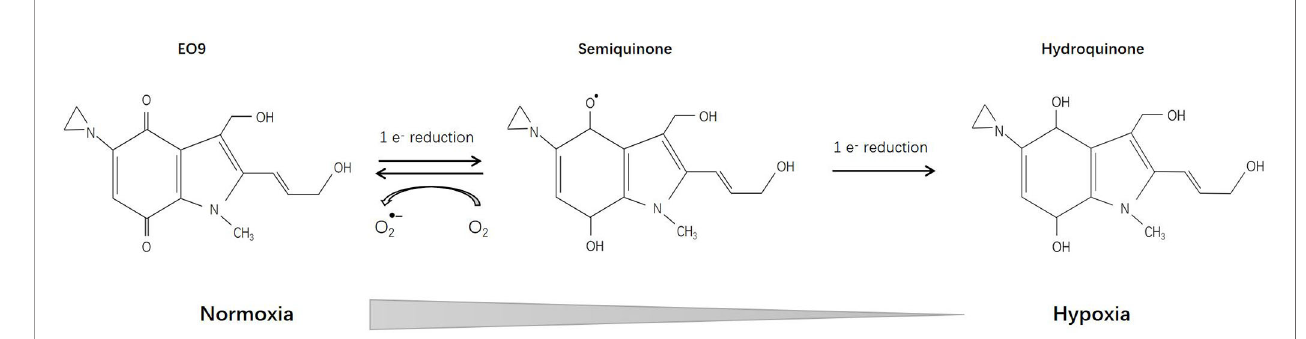
FIGURE 5 | Reductive reaction of